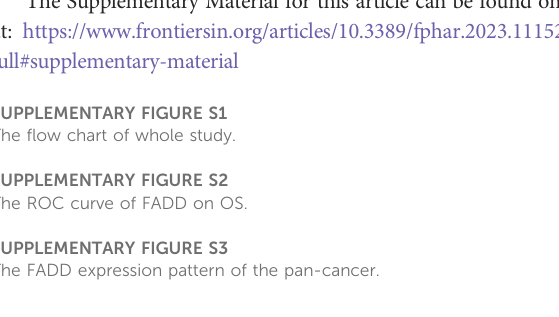
SUPPLEMENTARY FIGURE S1 The fl ow chart of whole study. SUPPLEMENTARY FIGURE S2 The ROC curve of FADD on OS. SUPPLEMENTARY FIGURE S3 The FADD expression pattern of the